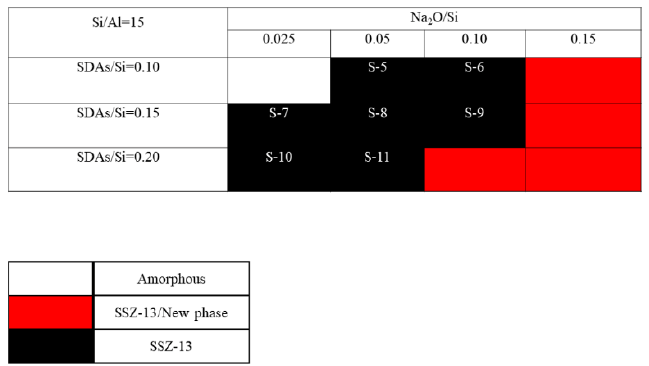
Figure 1. The crystallization of SSZ-13 with Si/Al = 8 as a function of the experimental variables in alkaline media. SDAs, structure-directing agents.